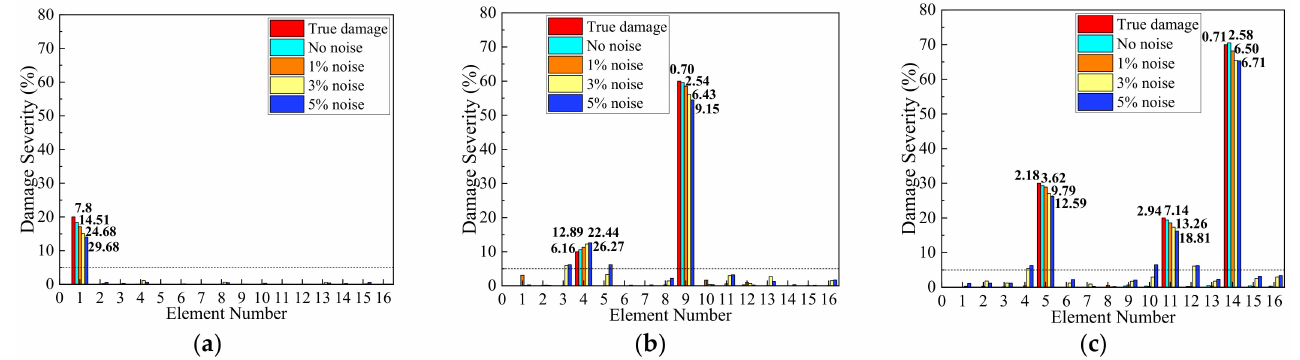
Figure 7. Damage identification results and corresponding errors using CNN. ( a ) Case 1; ( b ) Case 2; and ( c ) Case 3.